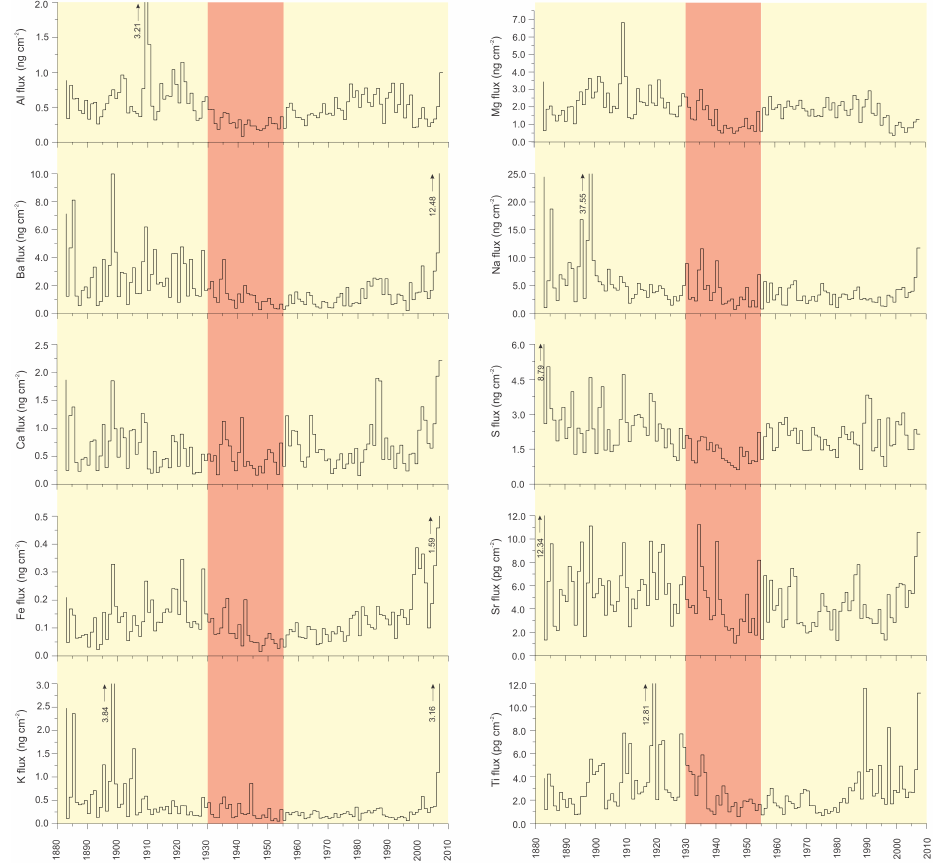
Figure 4. Annual fluxes of Al, Ba, Ca, Fe, K, Mg, Na, S, Sr, and Ti in the MJ ice core (Mn is not shown). Colored bands define three distinct phases in the record from 1883 to